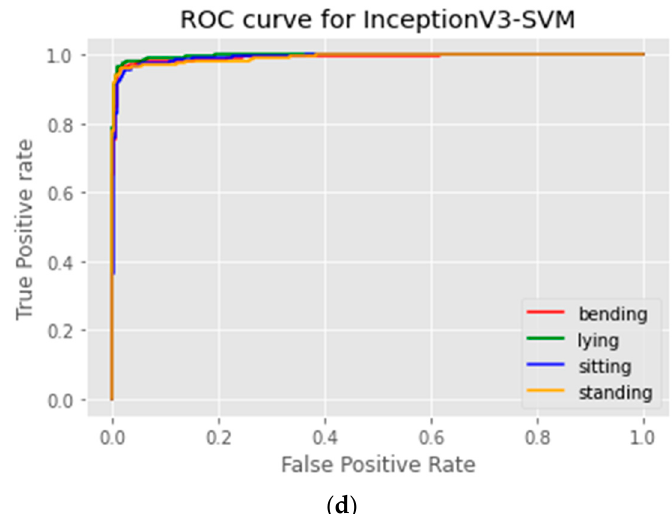
Figure 4. AUC-ROC curve of the DCNN models: ( a ) InceptionV3; ( b ) ResNet50; ( c ) DenseNet121; and ( d ) Proposed InceptionV3-SVM. Table 7. Results of the models on the test data set.